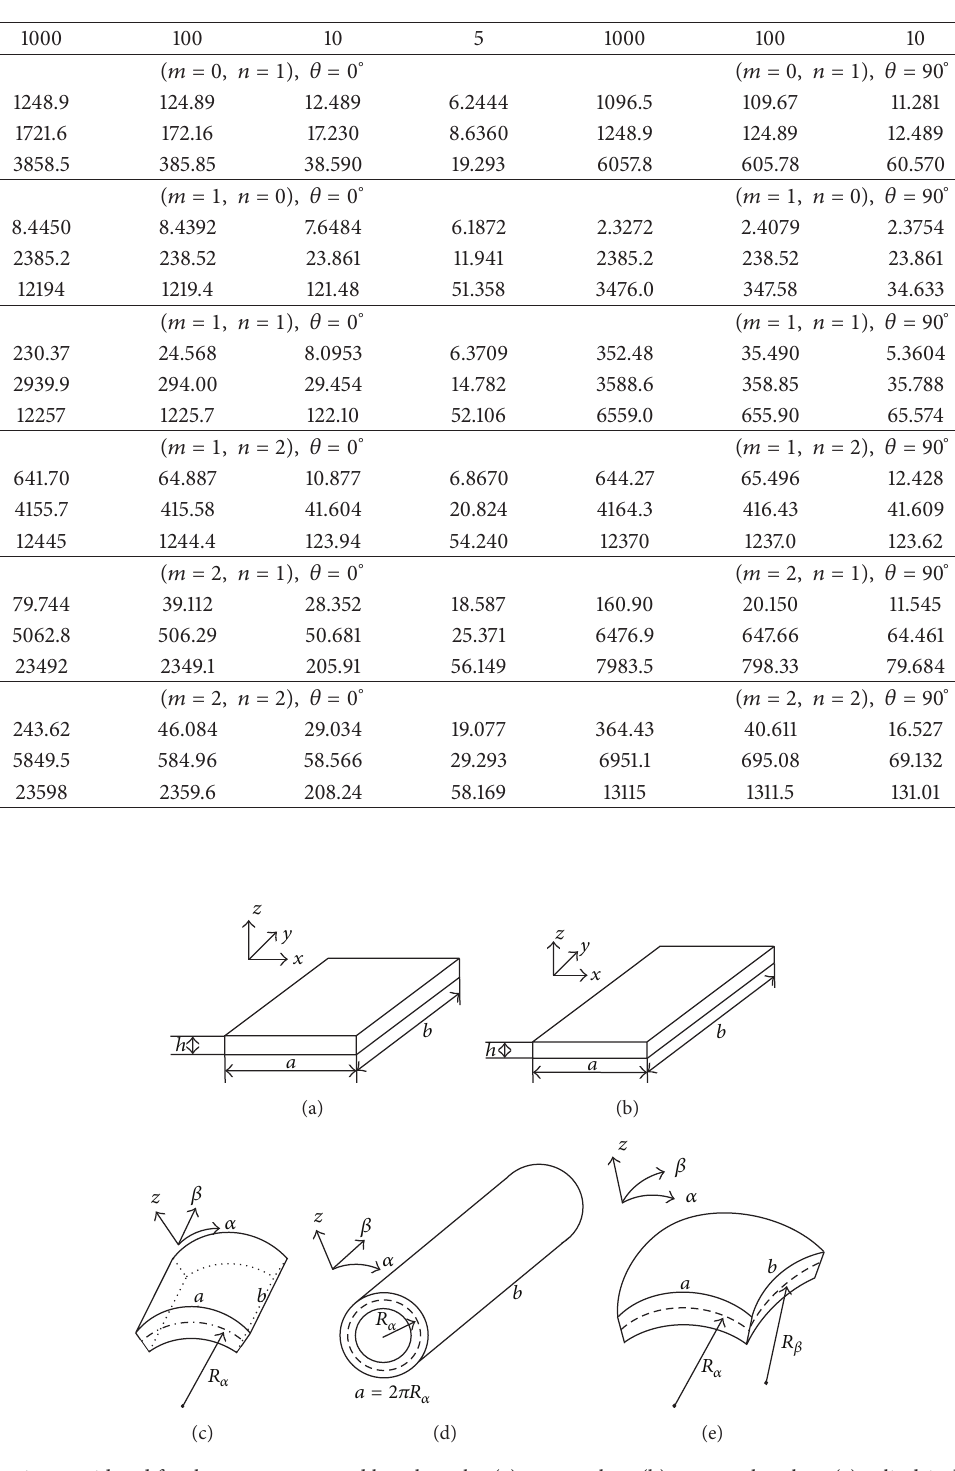
Figure 3: Geometries considered for the assessments and benchmarks: (a) square plate, (b) rectangular plate, (c) cylindrical shell panel, (d) cylinder, and (e) spherical shell